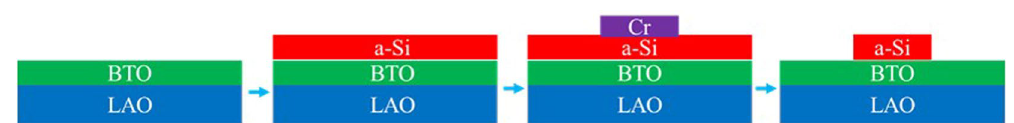
Figure 5. The fabrication process of the mid-IR waveguide sensor using Si-on-BTO platform. The epitaxial BTO film was grown on a (001) LAO substrate by PLD and then followed by a-Si thin film deposition through PECVD. Using photolithography and lift-off, the waveguide structure was first defined by a Cr mask, and then transferred to the a-Si layer by